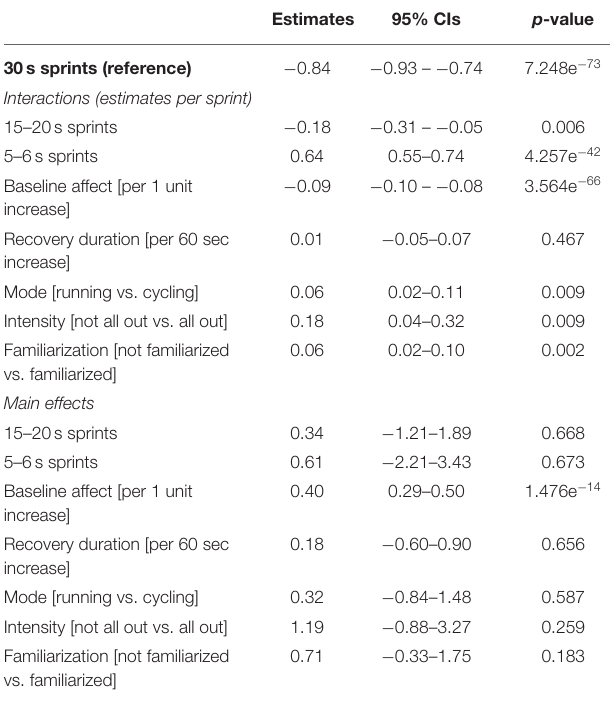
TABLE 2 | Effect of SIE protocol permutations on changes in affective valence during SIE.